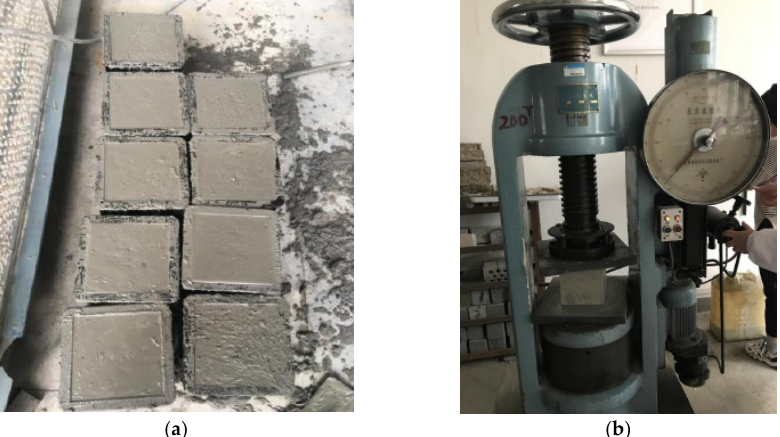
Figure 5. Concrete material properties experiments. ( a ) Standard concrete cube specimens; ( b ) Com- pressive strength testing of the cube. sive strength testing of the